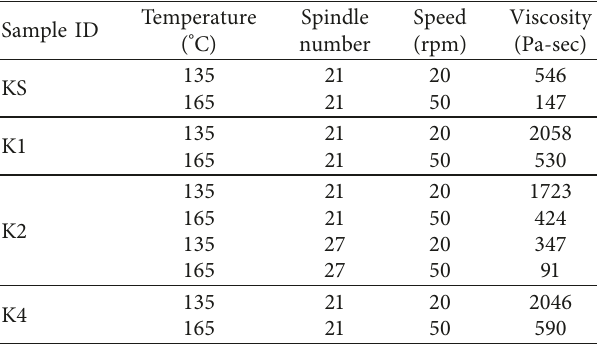
Table 2: Asphalt binder viscosity test results by rotational viscometer.